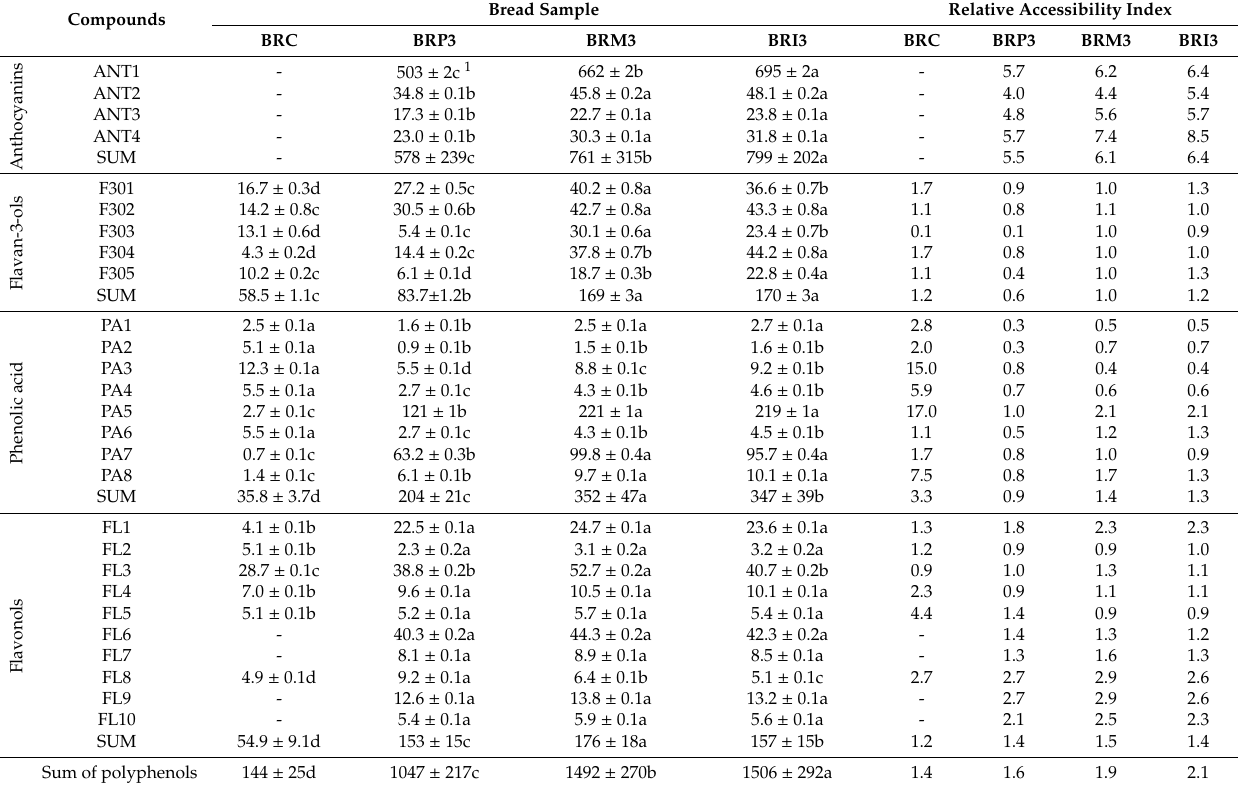
Table 3. Potentially bioaccessible phenolic compounds in the control and enriched rye